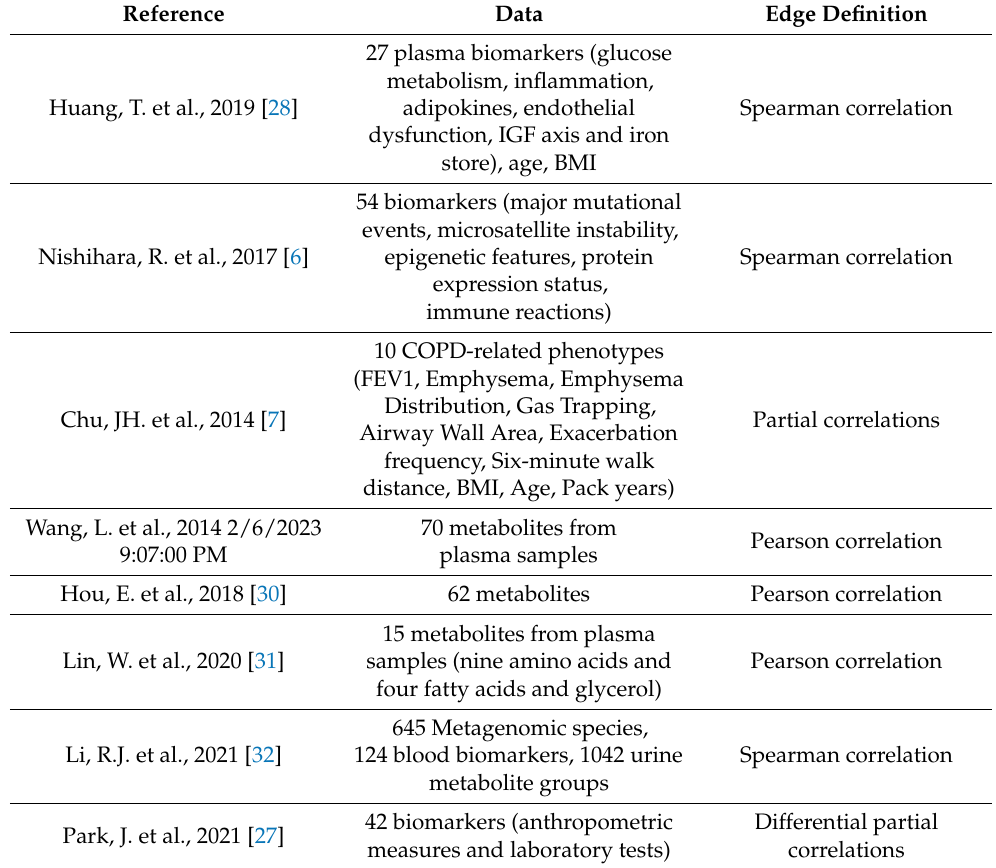
Table 1. Literature overview: methodologies to construct networks of biomarkers.